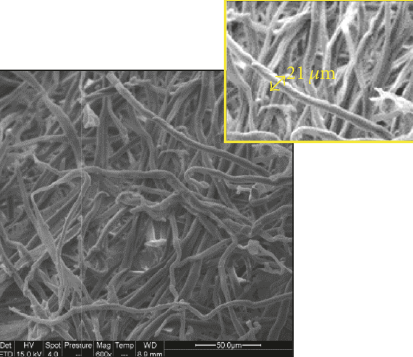
Figure 3: SEM image of Prunus amygdalus bleached pulp fibres. are less than 50), for example, P. chloranthus and Tamarisk